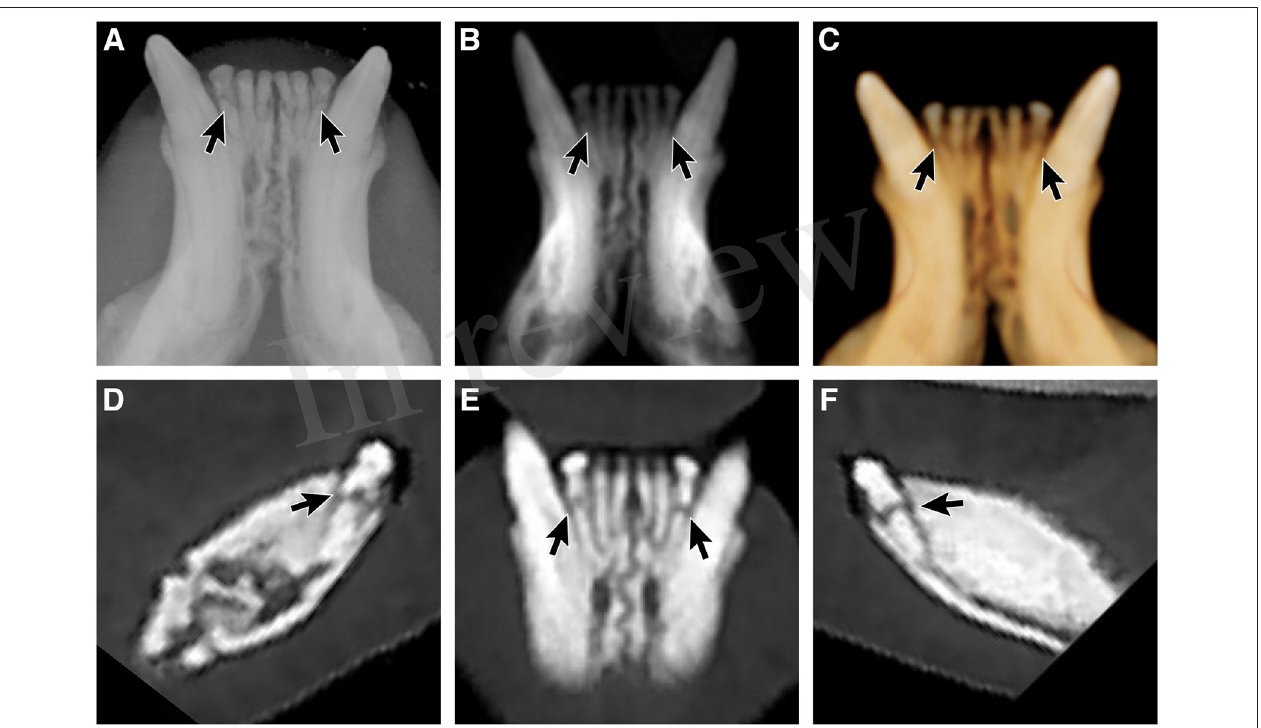
FIGURE 5 | Root fractures . Evaluation of the integrity of the left and right mandibular third incisor teeth demonstrating root fractures by way of (A) a mandibular occlusal radiographic view, (B) reconstructed panoramic CBCT viewing method with the axis of the skull adjusted for orientation of the left and right mandibular